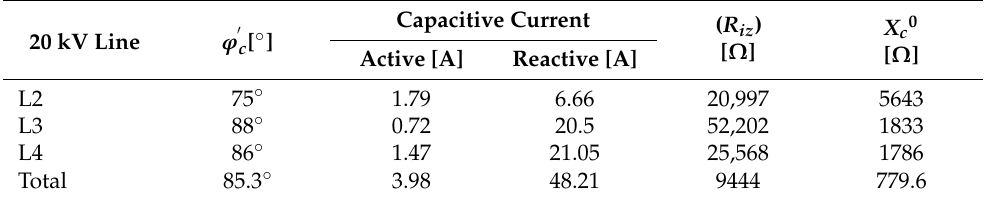
Table 2. The parameters of the 20 kV network without fault lines were determined experimentally. 20 kV